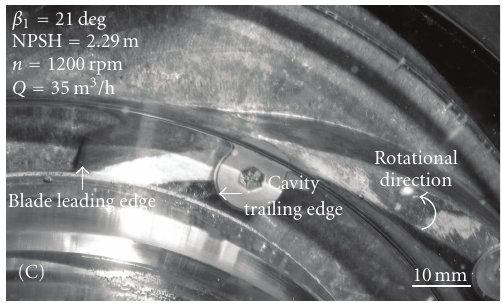
Figure 14: Illustration of cavitation for the blade leading edge angle of 21deg and NPSH equal to 2.29m.